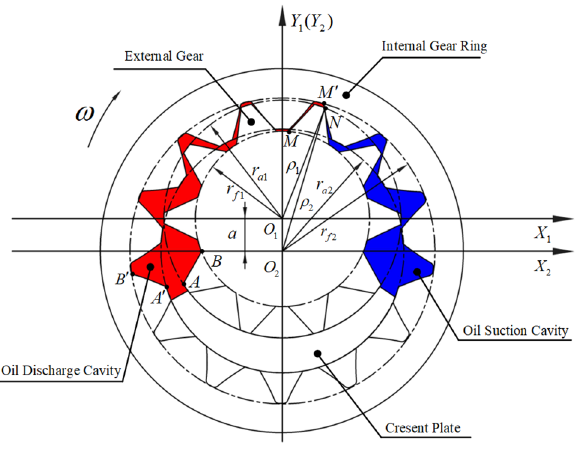
Figure 6. Schematic diagram of the vector ray